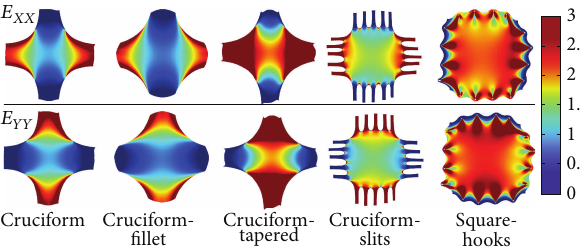
Figure 8: Contour maps of Green-Lagrange strains 𝐸 𝑋𝑋 , 𝐸 𝑌𝑌 .